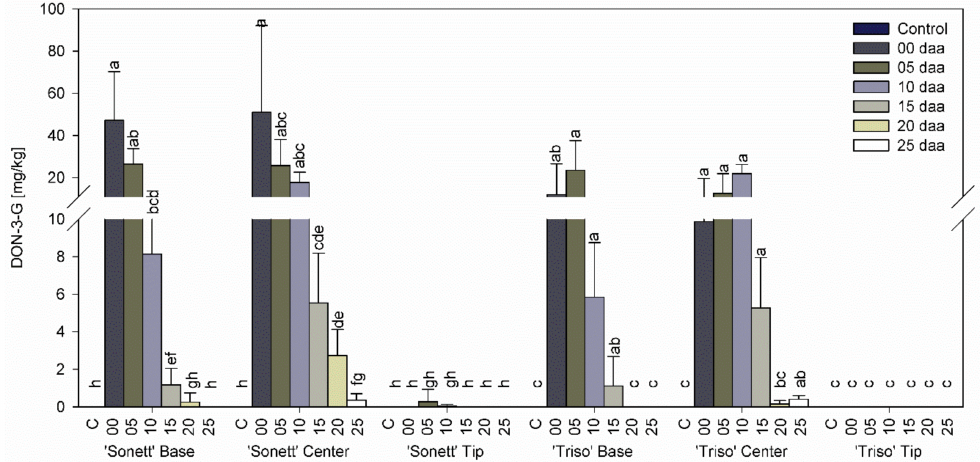
Figure 4. Deoxynivalenol-3-glucoside content in the tips, centers, and bases of the spikes of spring wheat varieties ‘Sonett’ and ‘Triso’ after inoculation of the central spikelets of the spike with Fusarium graminearum at different days after anthesis (daa), Kruskal–Wallis test ( p < 0.0001); n = 6; treatments with the same letters at the level of the variety are not significantly different.